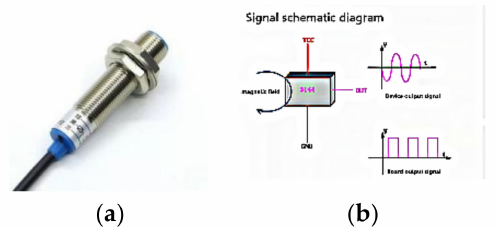
Figure 9. Hall sensor and principle. ( a ) Hall effect sensor;( b ) Schematic diagram